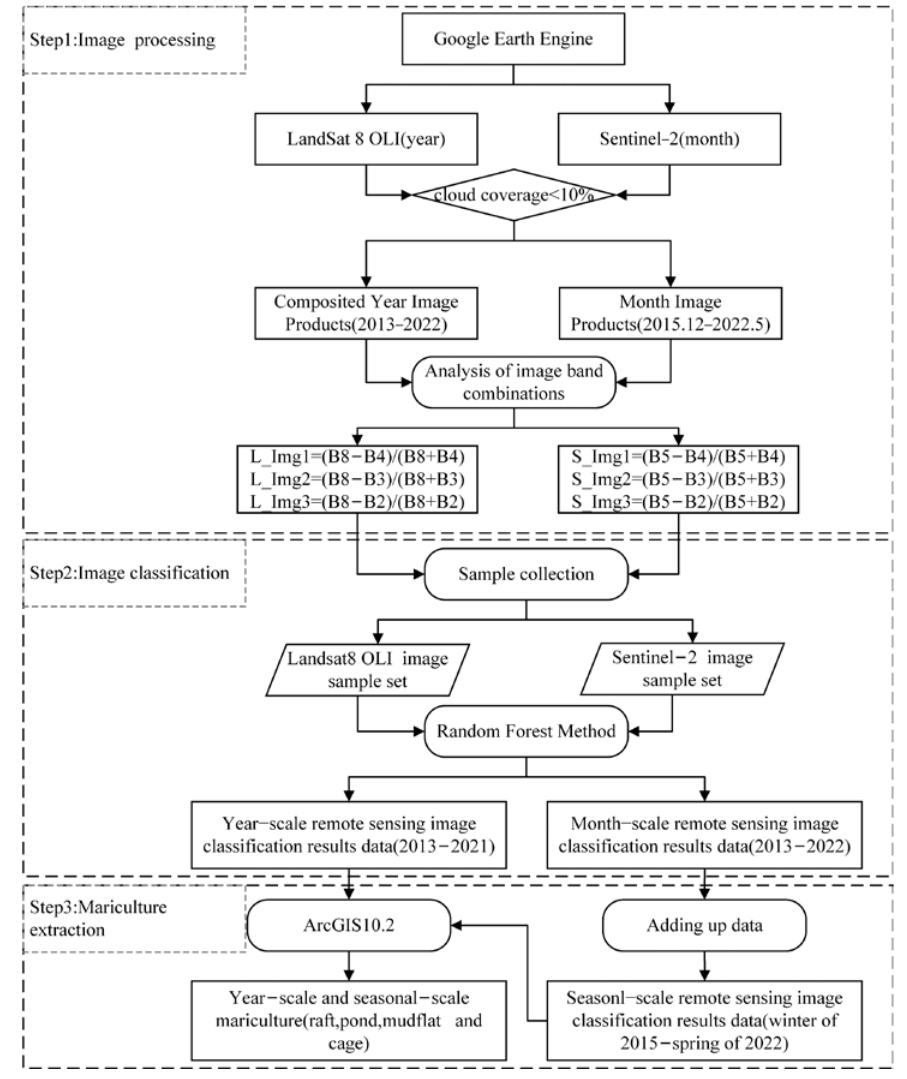
Figure 3. Flowchart for classification of types of mariculture.